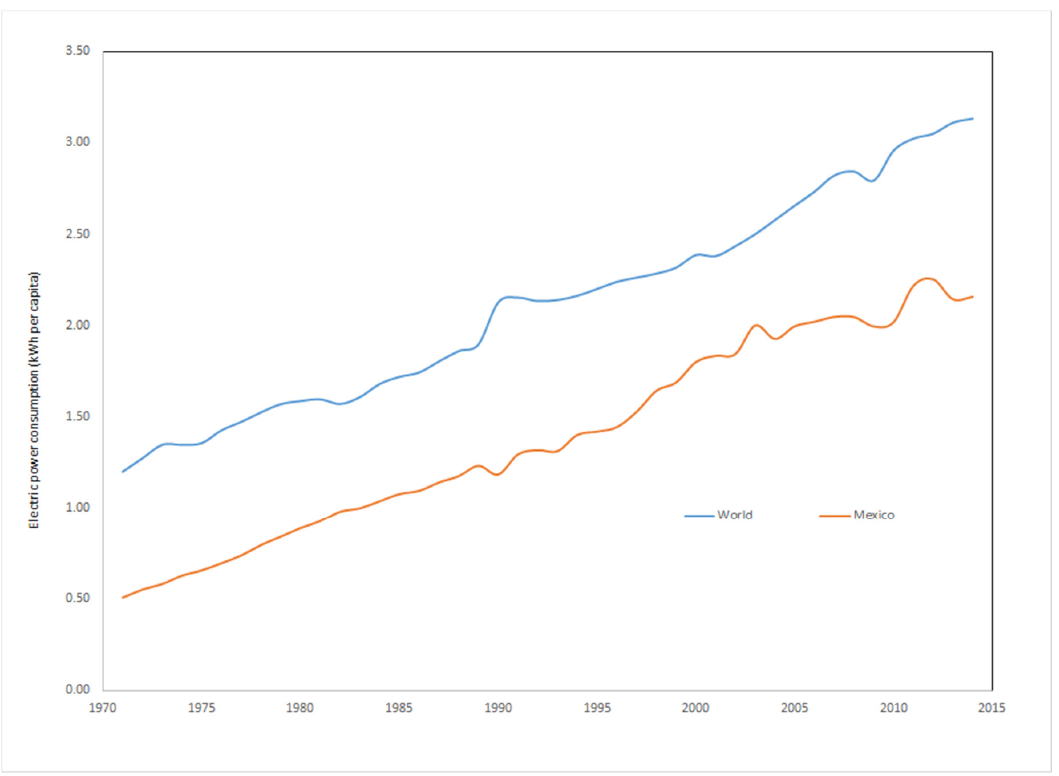
Figure 1. World and Mexico electric power consumptions. Prepared by the authors based on data from cited Reference [6].